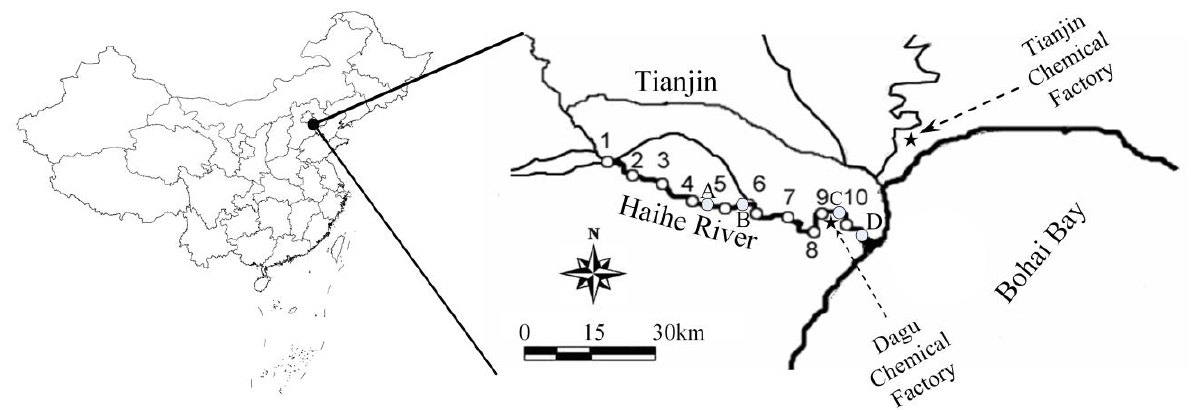
FIGURE 1. Sampling sites in the Haihe River. Water and sediment samples were taken from Sites 1–10. Four additional water samples were taken from sites A, B, C, and D in March